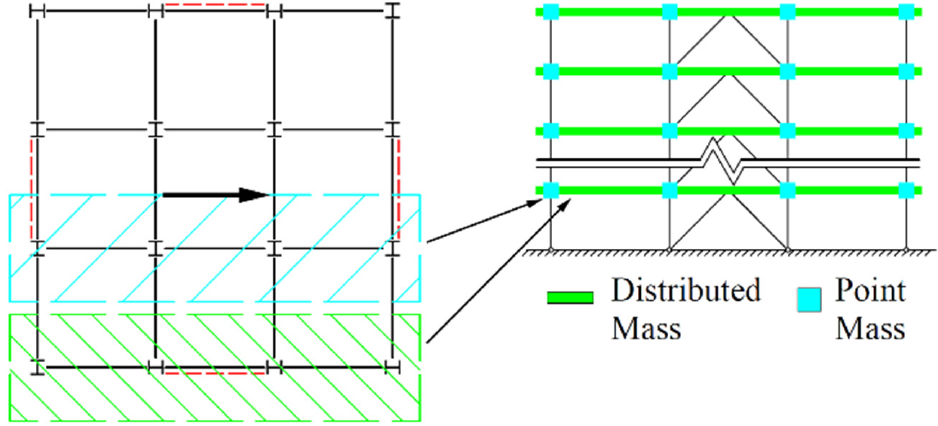
Figure 2. Allocation of floor mass.